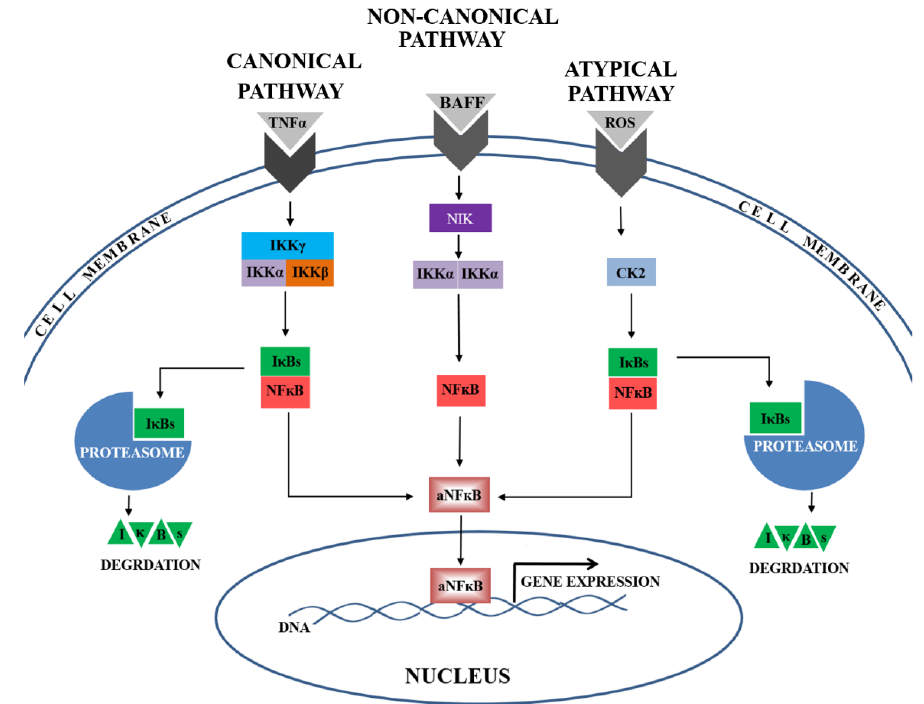
Figure 3. The canonical, non-canonical, and atypical NFκB signaling pathways are activated by multiple stimulants, e.g., TNF-α, BAFF or ROS. In the canonical pathway, the complex of